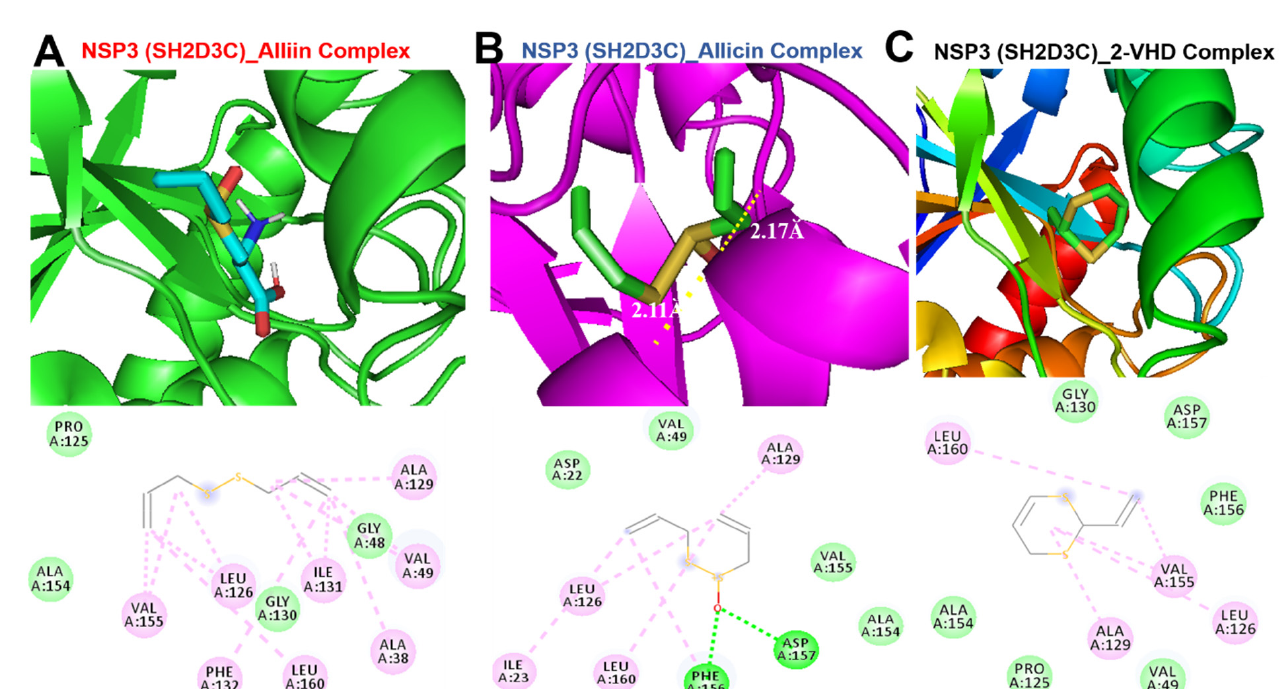
Figure 9. Molecular docking profile on NSP3 (PDB: 6W6Y) with the organosulfur small molecule from Allium sativum. Three- (3D) and Two- (2D) dimensional structure of the ligand − receptor interactions between NSP3 (SH2D3C) and ( A ) alliin, ( B ) allicin, and ( C ) 2-vinyl-4H-1,3-dithiin. Table 2. Docking profile of NSP3 (SH2D3C) with the organosulfur small molecule from Allium sativum. S-Allyl-Cysteine E-Ajoene Alliin